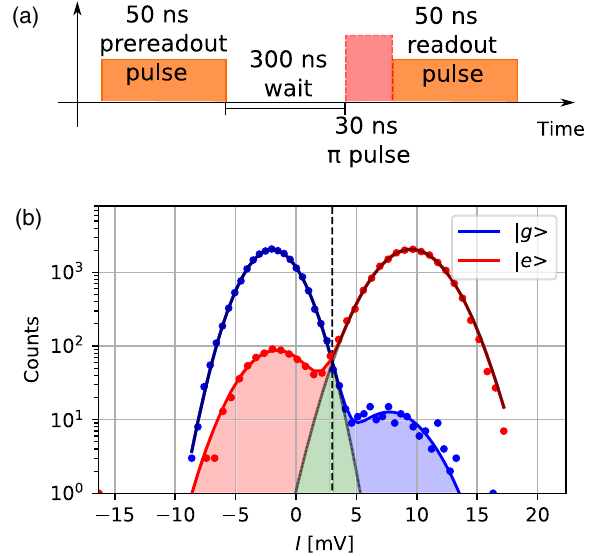
FIG. 5. (a) Pulse sequence sketch. (b) Histograms of 50-ns single-shot measurement for qubit prepared in ground state (blue points) and excited state (red points) with heralding. The solid blue and red lines are fits with a double Gaussian model. Black line is a single Gaussian fit. The green area depicts the overlap 0 . 8% . The blue and red areas indicate the remaining error ϵ o ¼ 0 . 6% and ϵ 3 . 9% , respectively. It leads to a error ϵ r;g ¼ r;e ¼ readout fidelity of 97.4%.